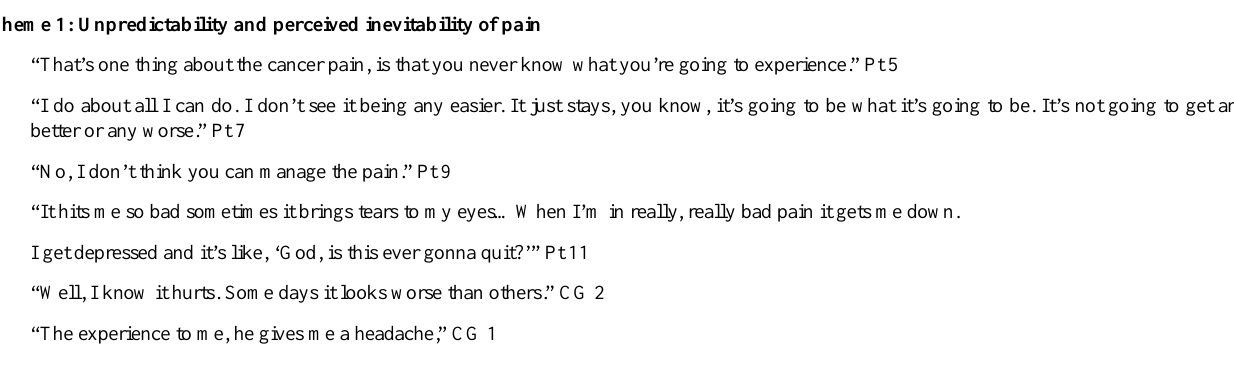
Textbox 1. Experience of managing cancer pain at home from the perspective of patients (Pt) and caregivers (CG). What is the experience of managing cancer pain at home? What is most